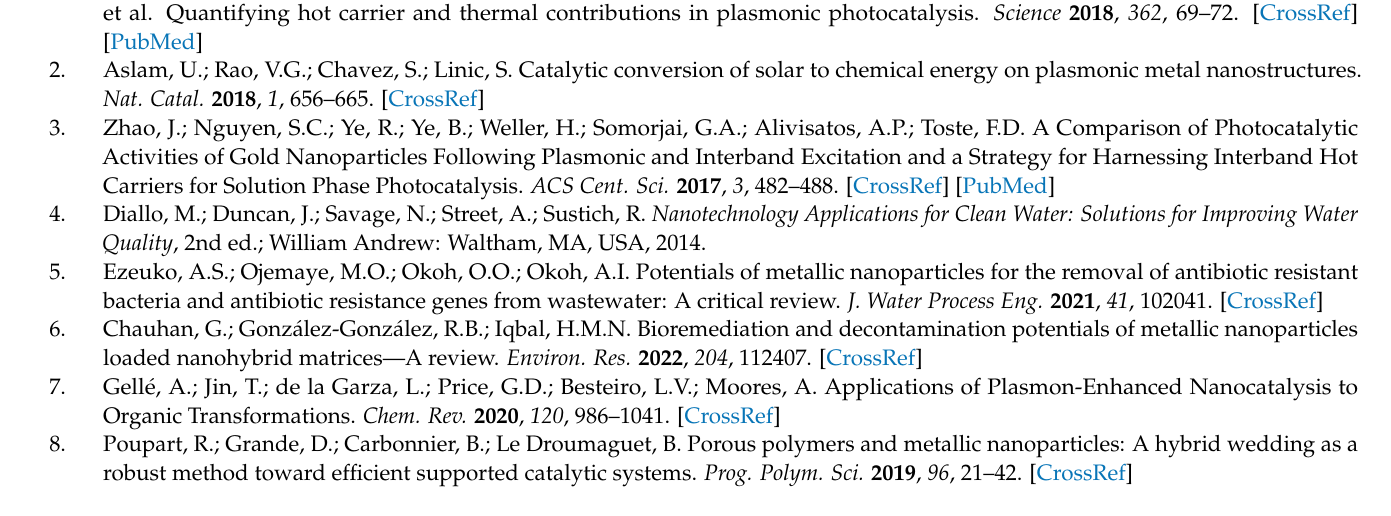
Figure S4: Reflectance spectra measured with an integrating sphere of the pristine wings on which later different amounts of Au sols were applied in Figure 4; Figure S5: SEM images of (a) a pedicel of a cover scale and (b) a socket which connects it to the wing membrane; Figure S6: Polyommatus icarus wing treated with Au sol. (a) Brown region can be observed where the coalescence of the Au nanoparticle occurred. (b) Normal incidence reflectance of the blue region of the wing and of the brown region of the same wing, where the coalescence occurred; Figure S7: X-ray diffractograms of the chitin in an as-received state (Pristine); after 6 h continuous stirring in deionized water (Water); and in sodium citrate solution (Citrate). One cannot observe any significant alteration in the XRD